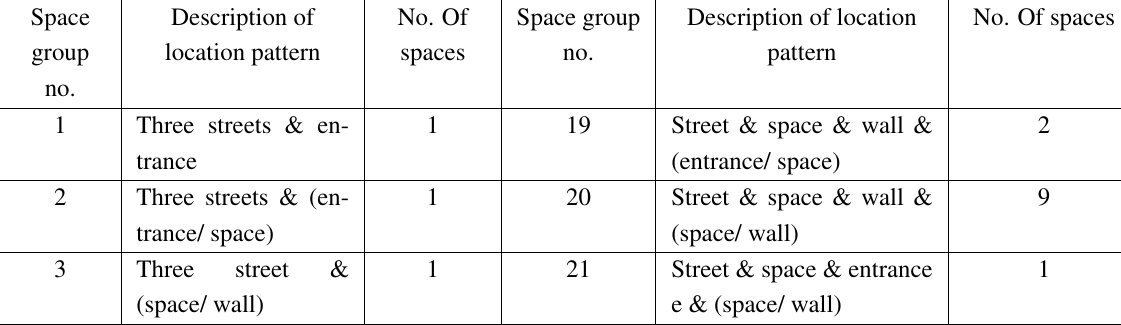
Table 1. The spaces location patterns